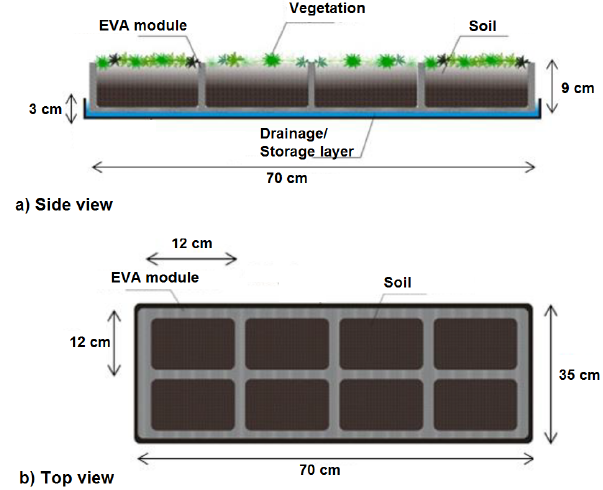
Figure 1. Modular green roof characteristics: side view (a) and top view (b)